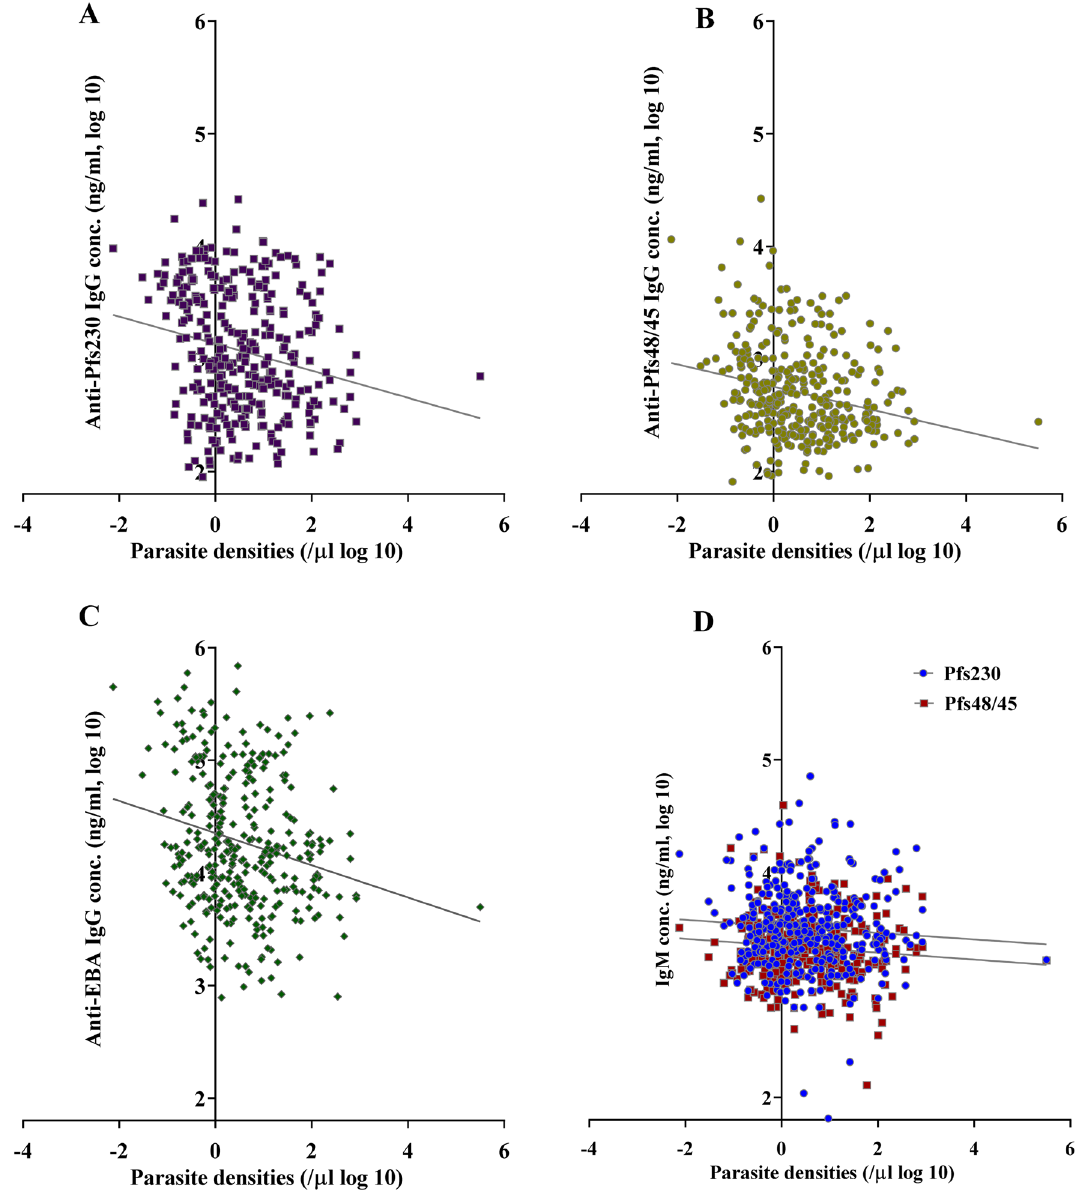
Figure 5. IgG antibody titers inversely correlate with parasite densities. Comparison of parasite densities estimated from Pf18s rRNA RT-qPCR analysis and the corresponding IgG ( A – C ) titers against Pfs230proC ( A ), Pfs48/45.6C ( B ) and EBA175RIII–V ( C ), and IgM ( D ) titers against Pfs230proC and Pfs48/45.6C. IgG, not IgM, responses were significantly inversely correlated with parasite densities. IgG Pearson r = − 0.2109****